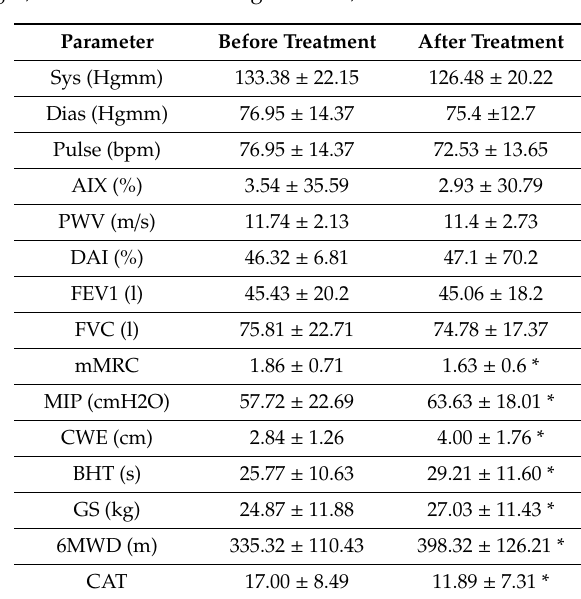
Table 1. Characteristics measured by Arteriograph and functional and quality of life marker parameters during a 4 week rehabilitation period (Sys: systolic blood pressure; Dias: diastolic blood pressure; AIX: augmentation index; PWV: pulse wave velocity; DAI: diastolic area index, FEV1: forced expiratory volume in the first second; FVC: forced vital capacity; mMRC: modified Medical Research Council Dyspnea Scale; MIP: maximal inspiratory pressure; CWE: chest wall expansion; BHT: breath holding time; GS: grip strength; 6MWD: 6 min walking distance; CAT: COPD assessment test; p <